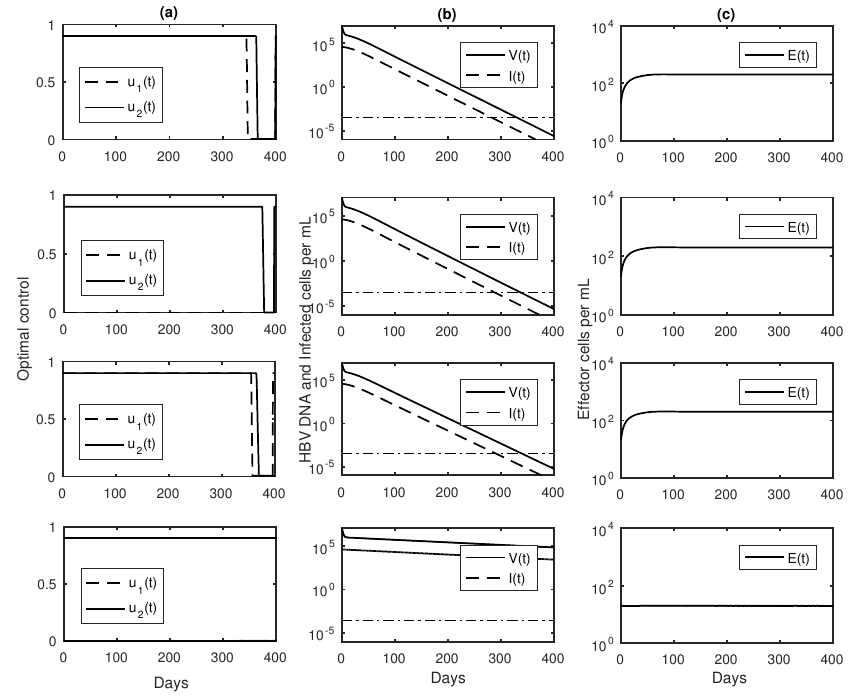
Figure 5. ( a ) Optimal evolution for controls u 1 (dashed lines) and u 2 (solid lines) as given by (15); ( b ) virus V per mL (solid lines) and infected cells I per mL (dashed lines) over time; ( c ) effector cells E per mL over time when drugs are introduced at equilibrium virus concentration and: a 1 = a 2 = a 3 = b 1 = b 2 = 1, f = 0.5 (top row); a 1 = a 2 = a 3 = 1, b 1 = b 2 = 0, f = 1 (second row); a 1 = a 2 = 0, a 3 = b 1 = b 2 = 1, f = 0 (third row); a 1 = a 2 = a 3 = 0, b 1 = b 2 = 1, f = 0 (bottom